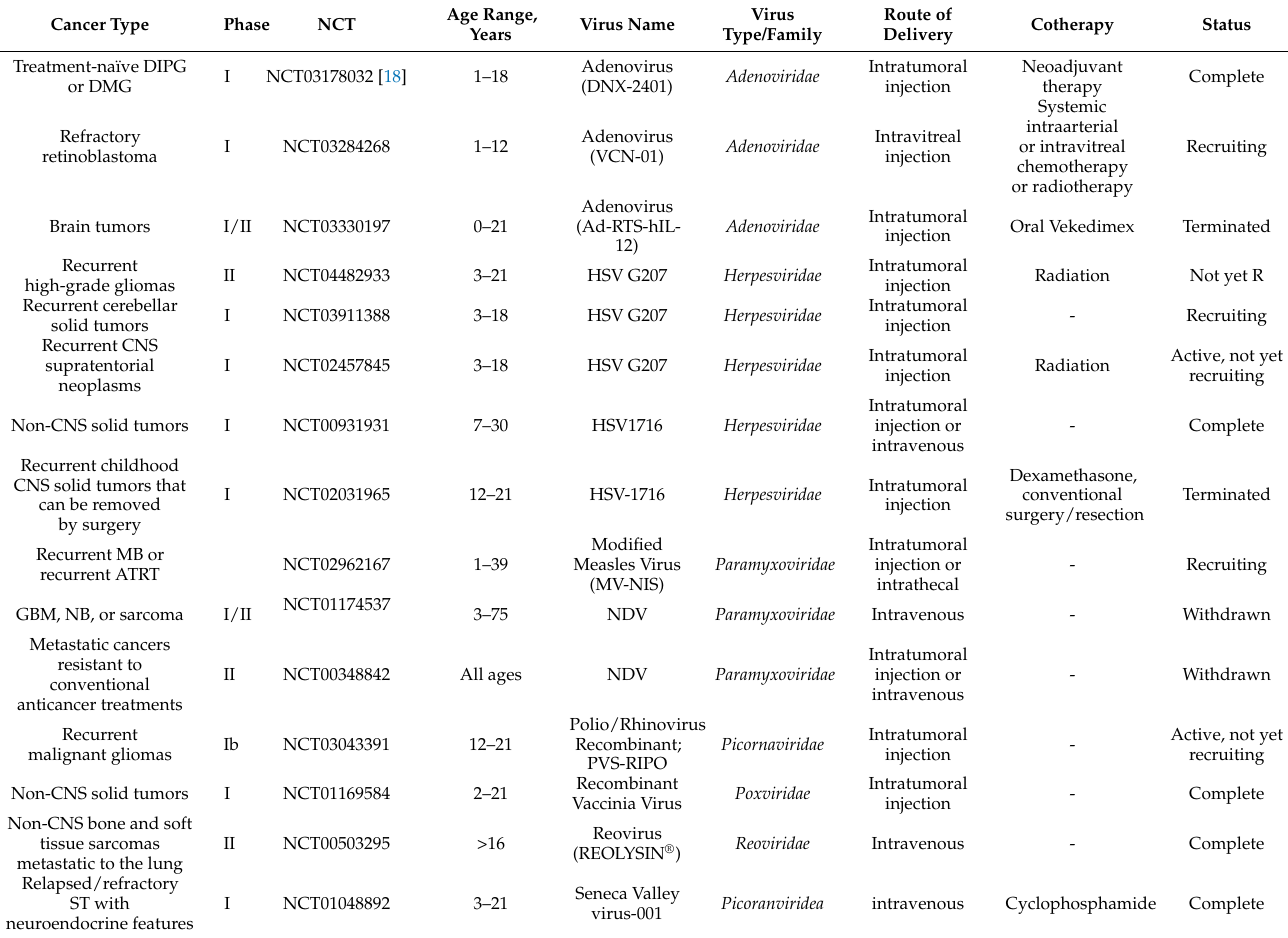
Table 2. Clinical trials of oncolytic virotherapy in pediatric patients with solid